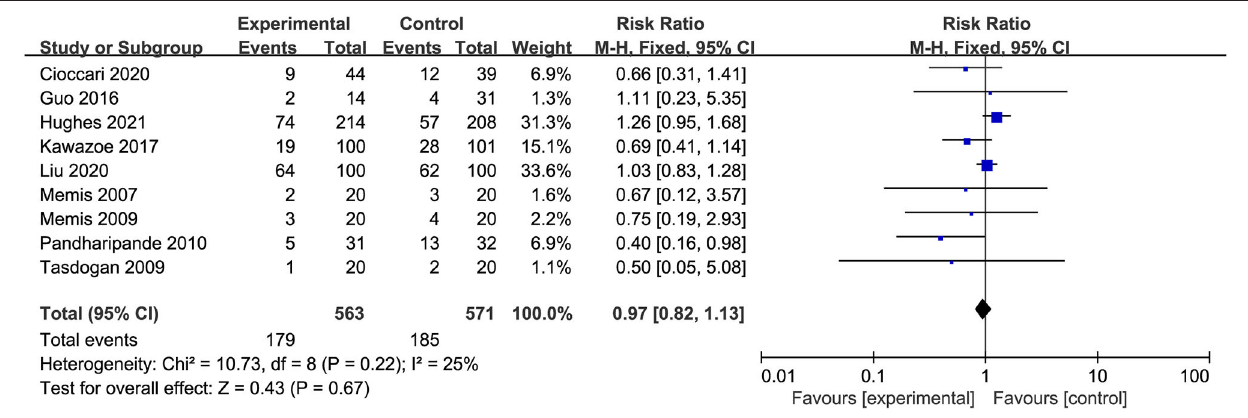
FIGURE 3 | Forest plot comparing the effect of DEX on